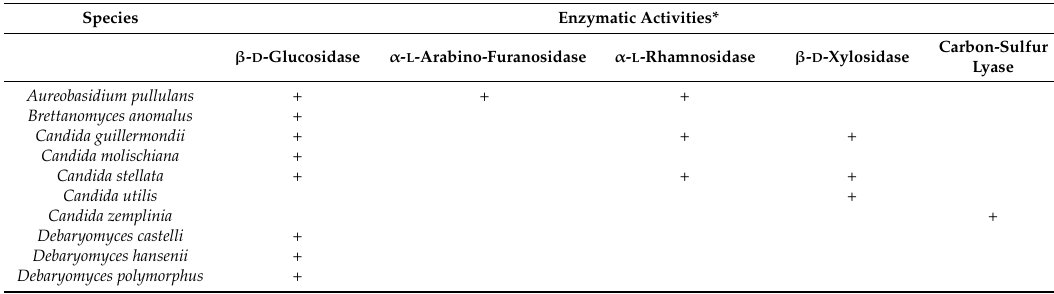
Aroma enhancing enzymes of non- Saccharomyces yeasts with possible use for wine fermentation modified from